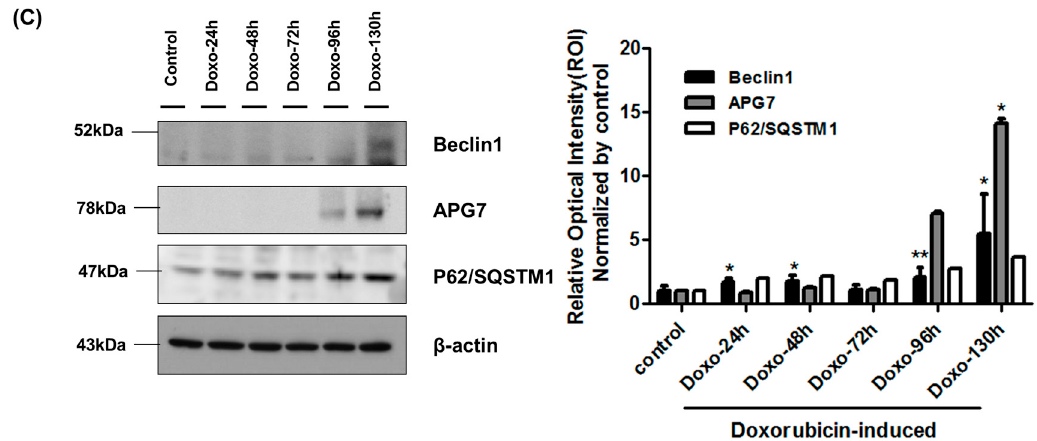
Figure 2. Effect of doxorubicin on expression of SMP30 and LC3. ( A ) The effect of 500 nM doxorubicin (acute dosage) on SMP30, LC3-I, and LC3-II protein expression at each time point, as detected by Western blot. The level of expression is shown in the bar graph on the right panel. * p < 0.05 versus control; ( B ) The effect of 100 nM doxorubicin (chronic dosage) on expression of SMP30, LC3-I, and LC3-II, as detected by Western blot. The level of expression was normalized to that of β -actin and is shown in the bar graph in the right panel. hCPCs at Passage 14 were used as senescence cells. * p < 0.05 versus control; ( C ) hCPCs were treated with 100 nM doxorubicin for 5 days, and we examined expression of autophagy-related proteins, Beclin-1, APG7 and P62/SQSTM1 by Western blot assay. * p < 0.05 versus DMSO treatment control; ** p < 0.01 versus DMSO treatment control.